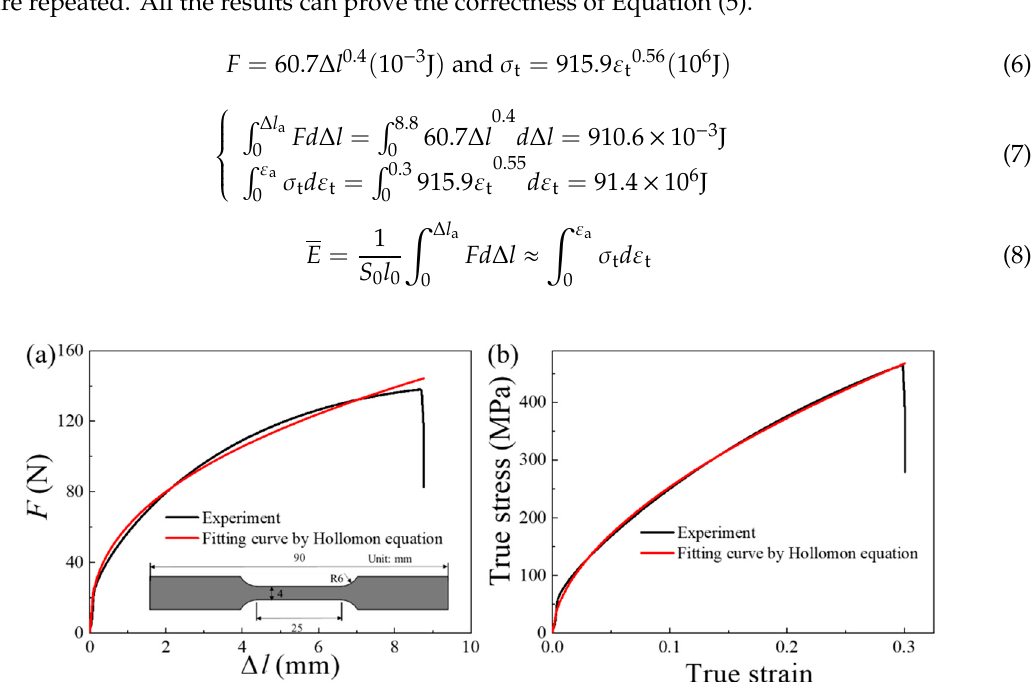
Figure 1. ( a ) Force ‐ displacement curve ( b ) True stress ‐ strain curve of the same specimen.